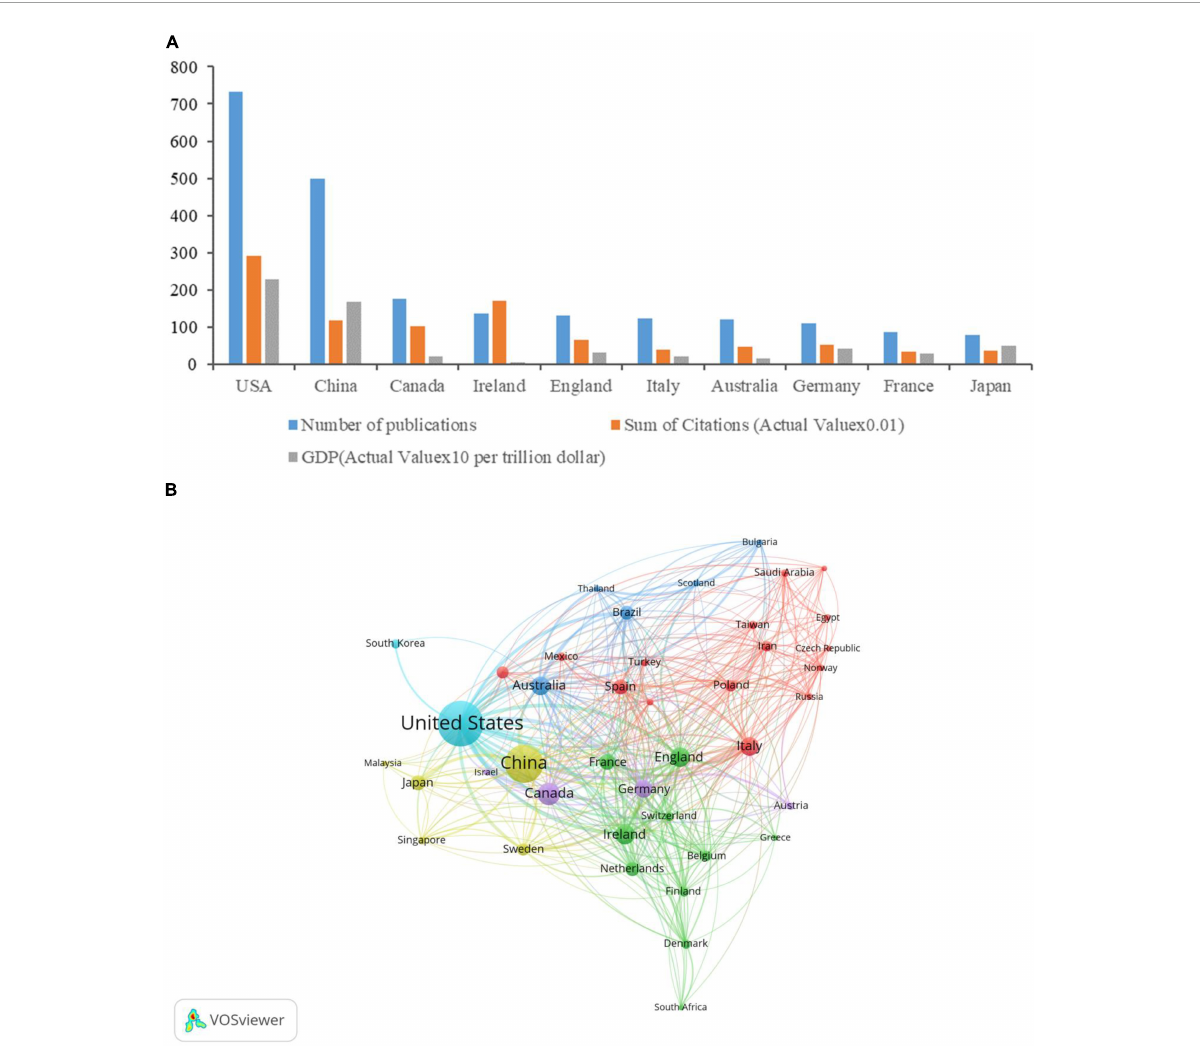
FIGURE2 Contributions of different countries/regions to research on gastrointestinal microbiome and neuroscience. (A) Number of publications, sum of citations (Actual Value × 0.01), and GDP (Actual Value × 10 per trillion dollar) in the top 10 active countries/regions. (B) Cooperation network of countries/regions to study the gastrointestinal microbiome and neuroscience. Map of countries/regions cooperation showed 41 countries/regions with a minimum of 10